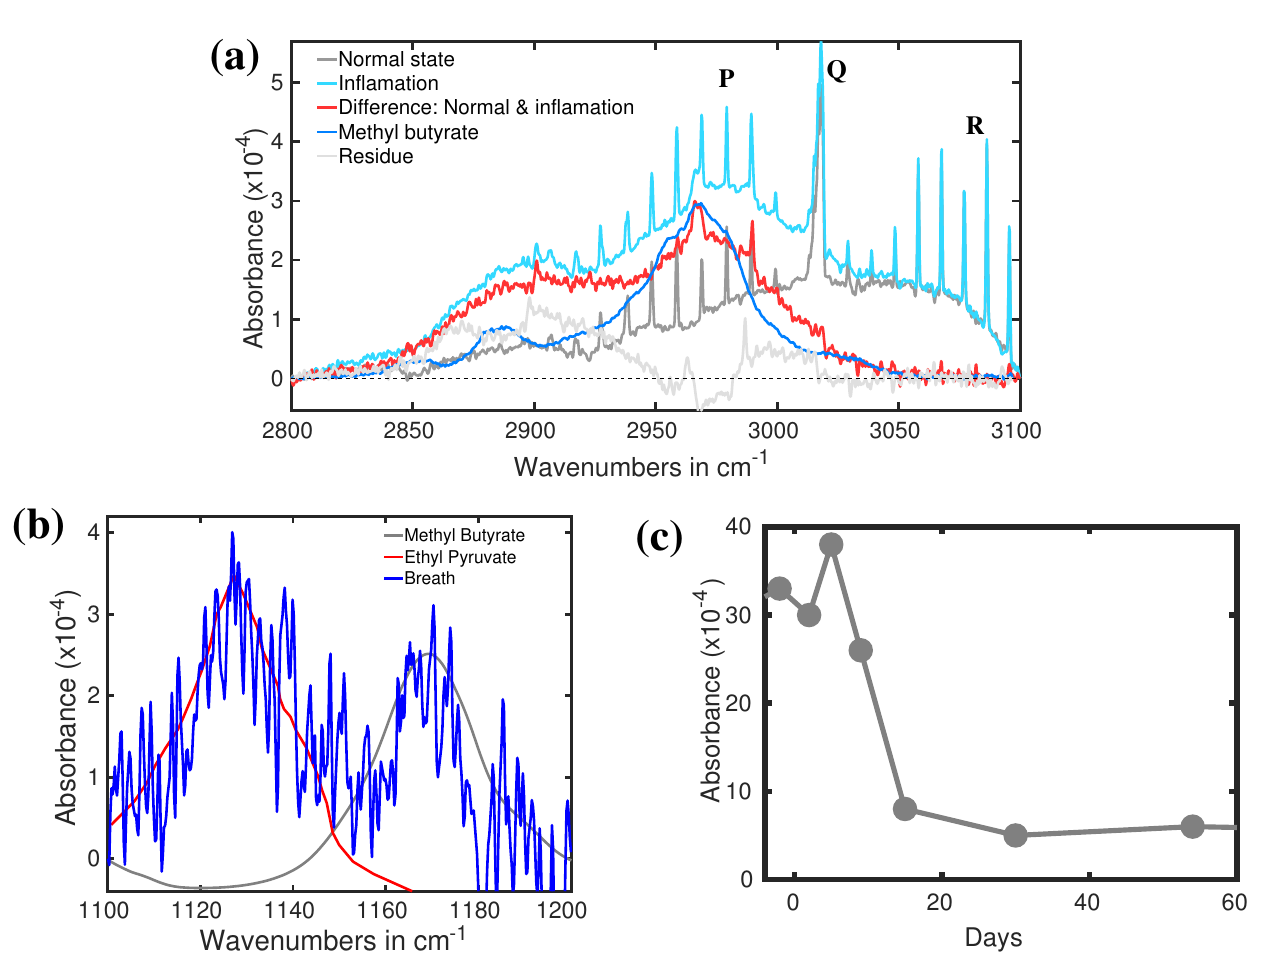
Figure 9. ( a ) Absorption spectra of breath when the person infected by bacteria. (Ref.[132]). ( b ) Ab- sorption spectra of the breath of a healthy volunteer (grey) and in bacterial infection (cyan). The red curve is the spectral difference between the above two spectra. The blue plot represents the IR spectrum of methyl butyrate. (Ref.[122]). ( c ) The recovery dynamics of acute gastritis via QAC.